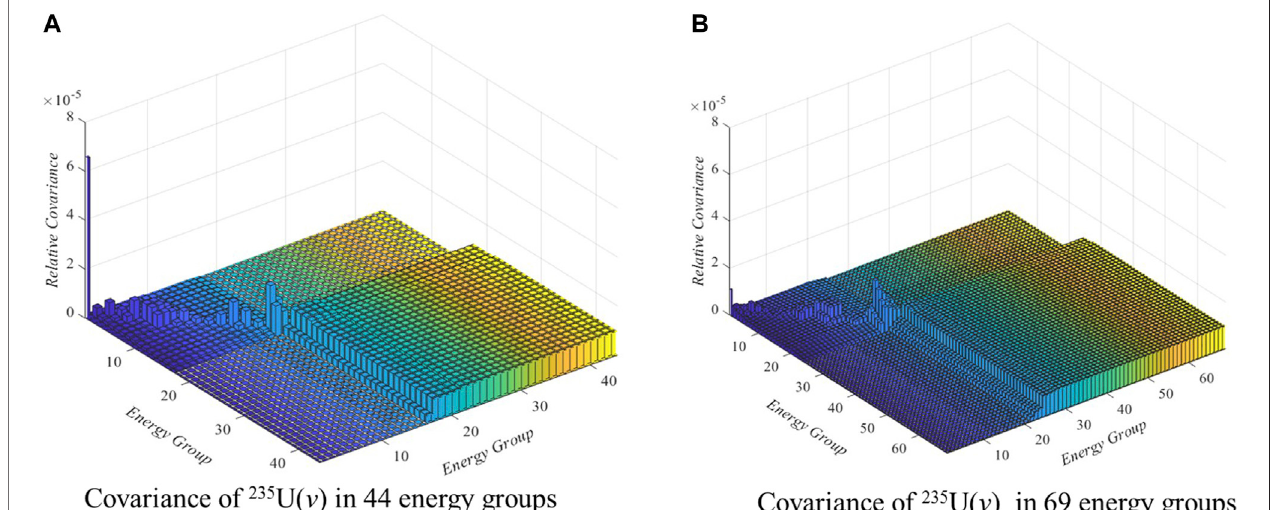
FIGURE 4 | Comparison of relative covariance matrix for 235 U ( v ).